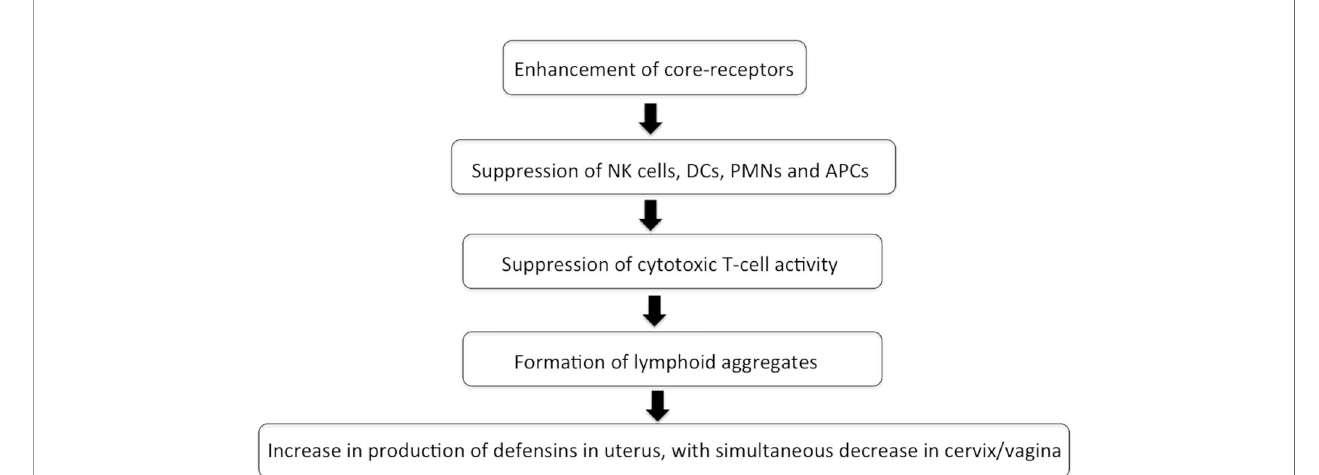
FIGURE 1 | Flowchart depicting the effect of sex hormones during menstrual cycle on immune system in